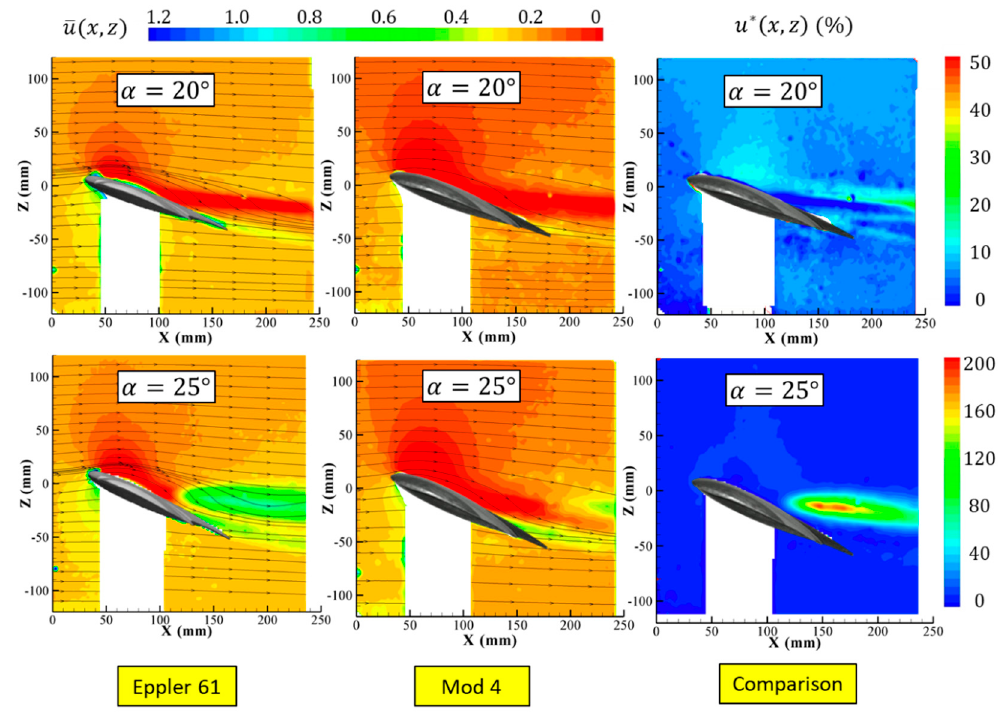
Figure 12. Comparison of the velocity maps in Section S 2 , for angles of attack 20 ◦ and 25 ◦ .